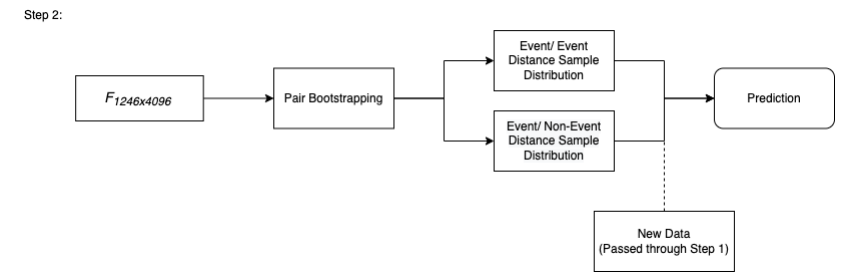
Figure 5. Diagram illustrating the process by which new predictions are